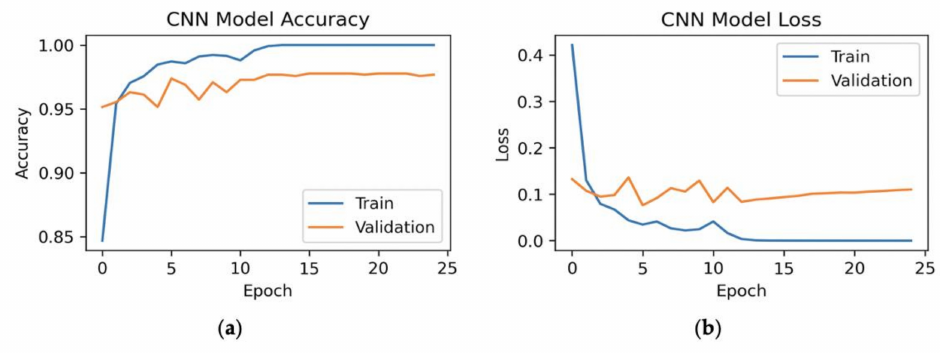
Figure 18. Experimental results for 164 features: ( a ) epoch vs. accuracy and ( b ) epoch vs. loss. Figure 19 shows the effect of number of features on accuracy for the current split ratio.